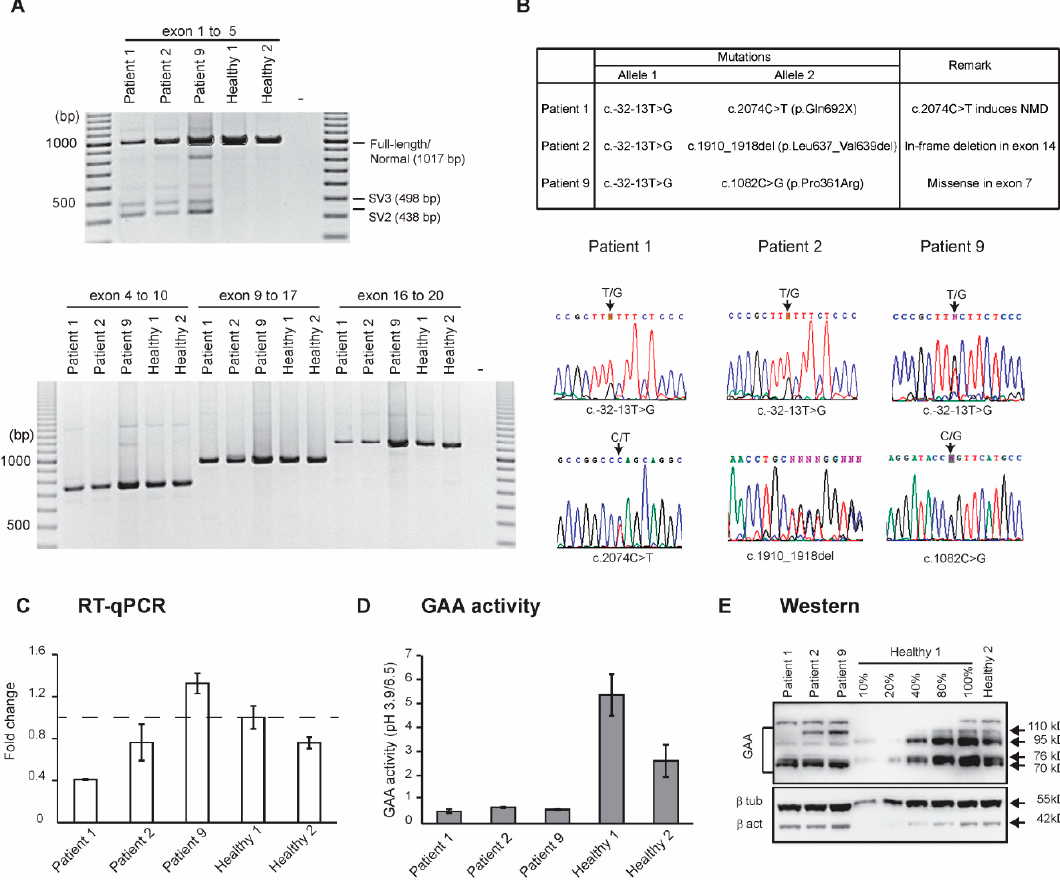
Figure 1. ( A ) RT-PCR analysis of GAA transcripts from fibroblasts derived from three Pompe patients and two healthy controls. ( B ) The mutations were identified and confirmed using Sanger sequencing for the three patients. The c.-32-13T > G and c.2074C > T mutations were identified from genomic DNA and the c.1910_1918del and c.1082C > G from RT-PCR products. ( C ) RT-qPCR analysis of the full-length GAA transcript containing exon 2. ( D ) GAA activity (N = 3, Error bar = SD) and ( E ) western blotting analysis of GAA (110, 95, 75 and 70 kD) from fibroblasts derived from three patients and two healthy controls.